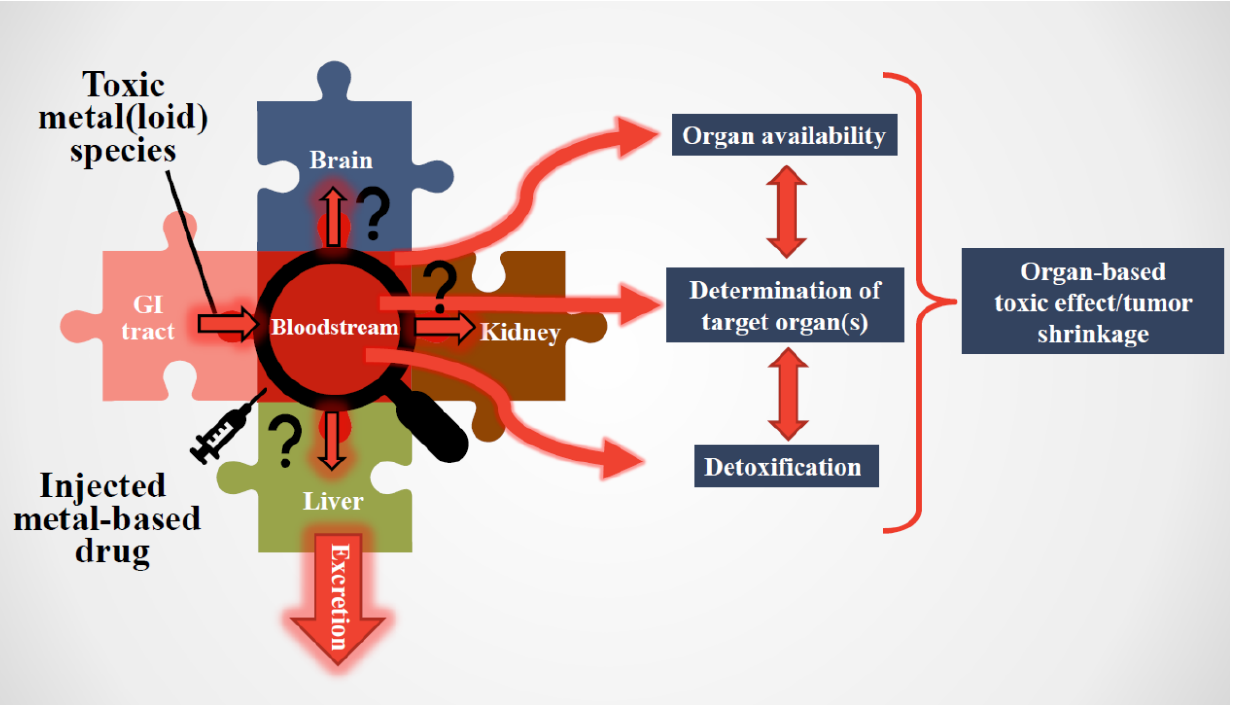
Figure 1. The central role held by the bioinorganic chemistry of toxic metal(loid) species and metallodrugs in the bloodstream in terms of linking environmental exposure to adverse health effects/organ-based diseases and in developing better drugs to treat human diseases, such as cancer (Figure modified from [13] ).